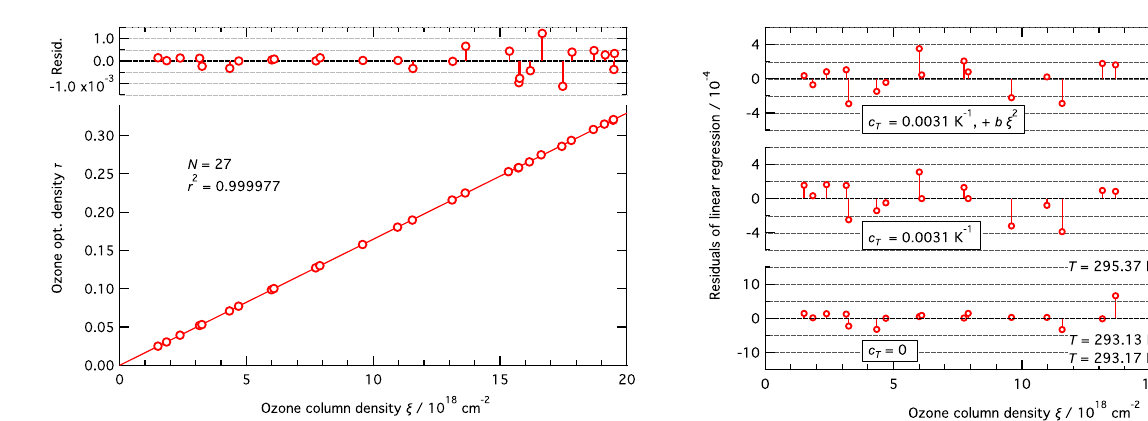
Figure 5. Study of residuals in the fitting of the absorption data us- ing different variants of Eq. (17) as fitting functions. From bottom to top, the number of free fit parameters increases. The result of a simple linear fit ignoring the temperature dependence of the ab- sorption cross section ( c T = 0 in Eq. 17) is shown on the bottom. Residual values with highest and the two lowest sample temper- atures are indicated. The same fit including a temperature depen- dence ( c T = 0 . 0031K − 1 ) is displayed on the middle panel. The top panel shows residuals when the fit includes an additional quadratic term ( + bξ 2 ) in the ozone column density. Scales in the two upper graphs are enlarged by a factor of